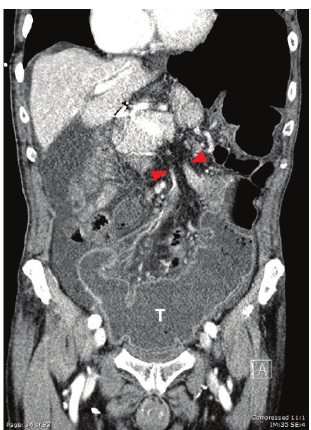
Figure 3: Gross specimen showing the Meckel’s diverticulum (M) in relation to the terminal ileum (TI) and the proximal surgical staple line (red arrows). As shown, the Meckel’s diverticulum had a relatively broad base; its measurements were 3.5 × 3.0 × 2.5 cm.